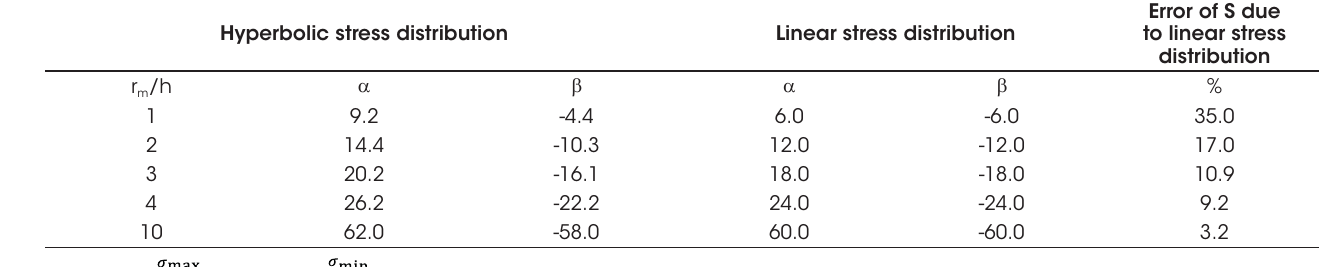
Statistical analysis of the design procedure used in reinforced concrete pipes